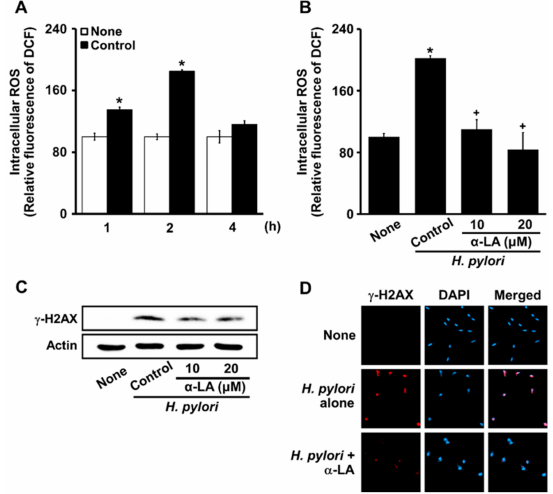
Figure 3. α -LA suppresses the H. pylori -induced increase in ROS levels, H2AX phosphorylation, and γ -H2AX foci formation in AGS cells. ( A ) Cells stimulated with an H. pylori ratio to cells of 100:1 for up to 4 h. The cells were incubated with α -LA at indicated concentrations for 2 h then stimulated with an H. pylori ratio to cells of 100:1 for 2 ( B ) and 24 ( C , D ) h. ( A , B ) ROS levels shown were determined using 2 (cid:48) ,7 (cid:48) -dichlorofluorescin diacetate (DCFH-DA) assays. All of the data are presented as means ± S.E. of three independent experiments. * p < 0.05 vs. none (unstimulated cells without α -LA); + p < 0.05, vs. Control (cells stimulated by H. pylori without α -LA). ( C ) Western blots of γ -H2AX in whole-cell extracts. Actin was the loading control. ( D ) Cells and nuclei were stained with anti- γ -H2AX antibody (red) and DAPI (blue),